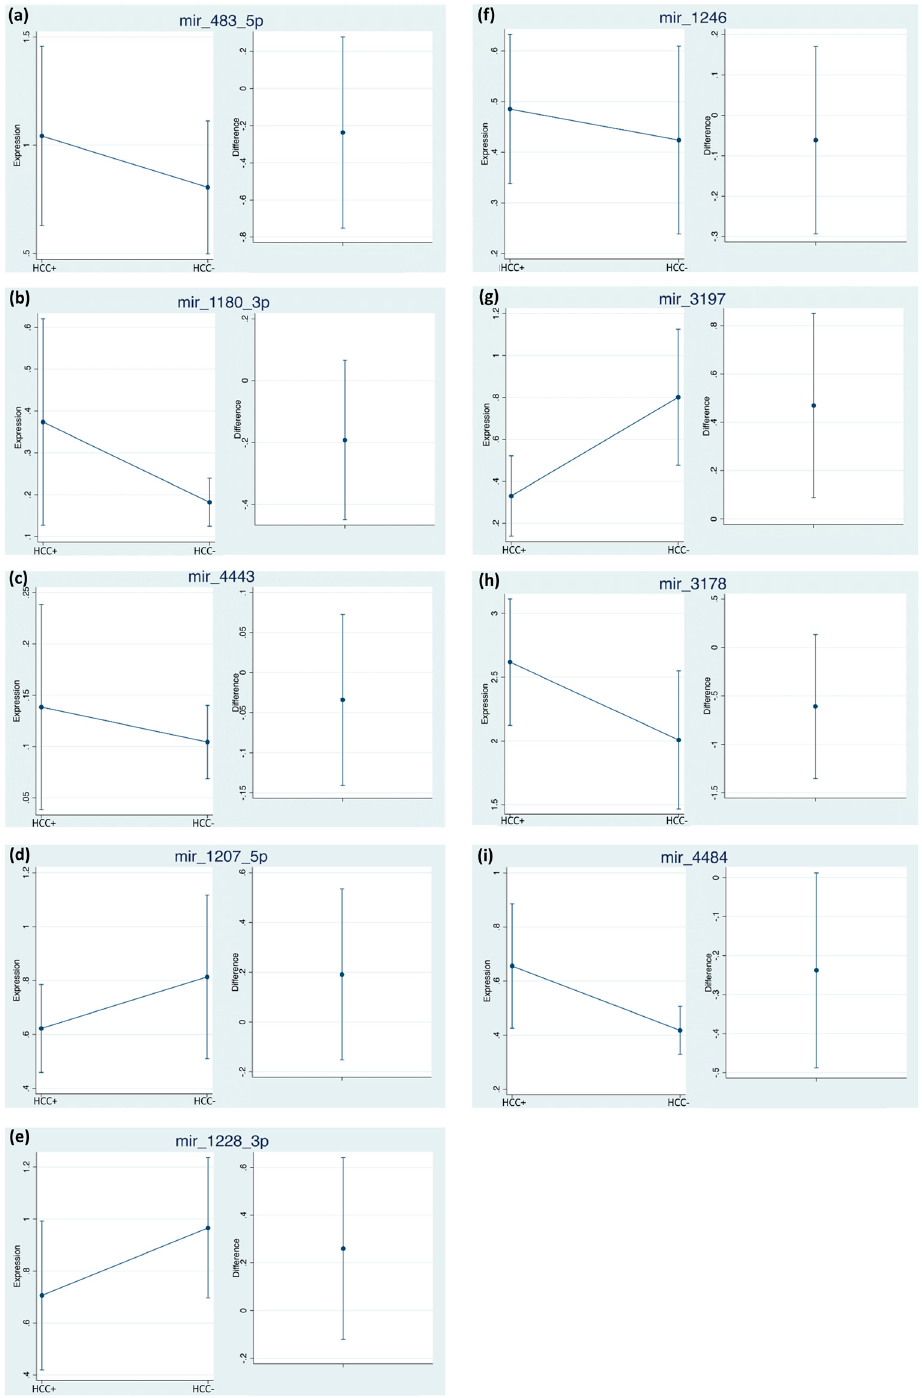
Figure 3. ΔΔ Cq time-averaged differences of miRNAs between subjects HCC+ vs. HCC − . The estimates were obtained using bootstrapped random-effect generalized least square regression (RE-GLS). Internal cross-validation was performed using bootstrap on 1000 samples with replacement (see statistical analysis for details). The difference is calculated as (HCC+ minus HCC − ), values showing 95% CI crossing 0 are not statistically significant at the 0.05 level.